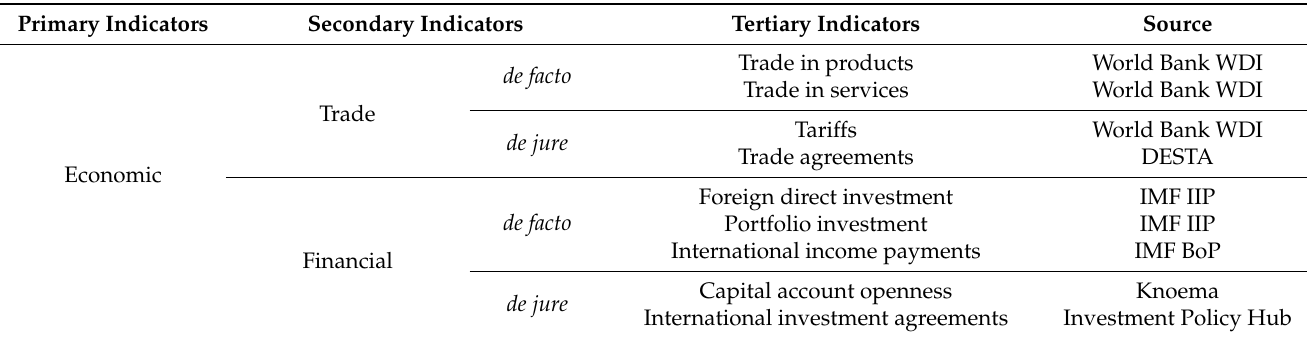
Table 1. The globalization index: Variables